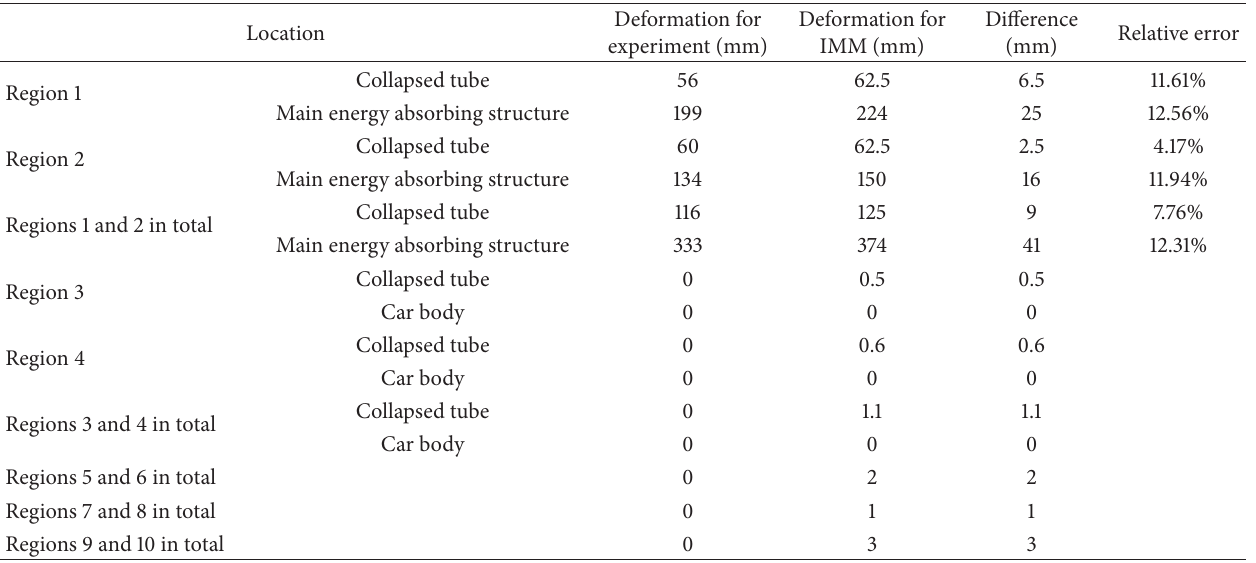
Table 4: Comparison of deformations between experiment and IMM.